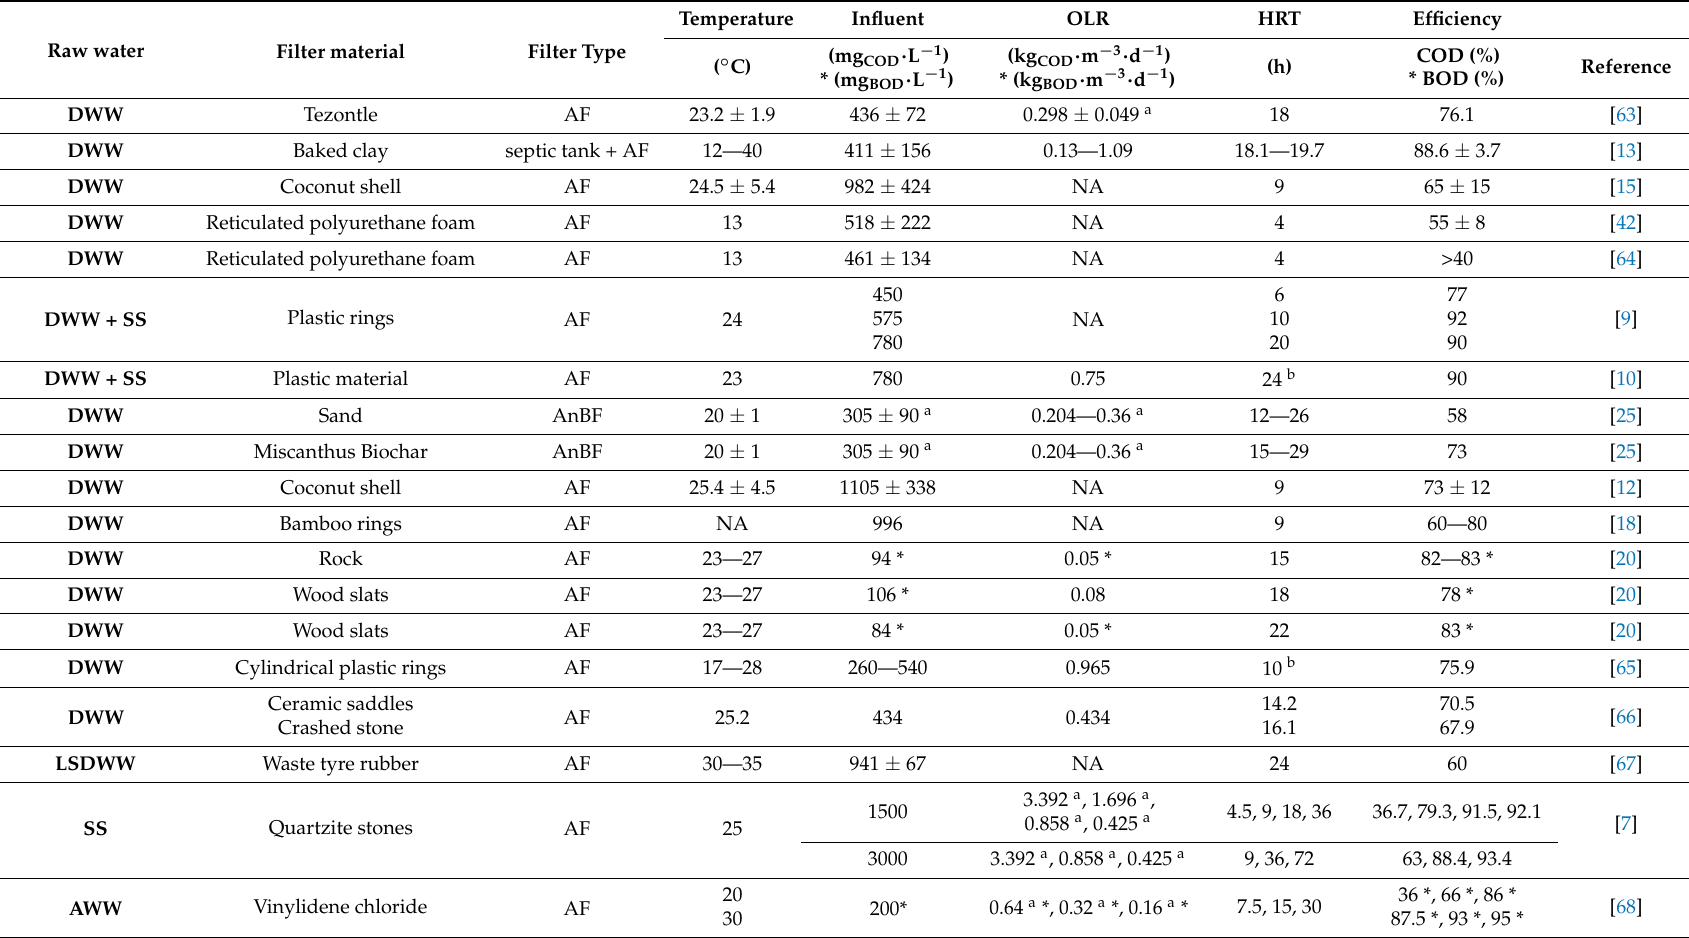
Table A1. Literature review of anaerobic filter (AF) and anaerobic biofilter (AnBF) for wastewater